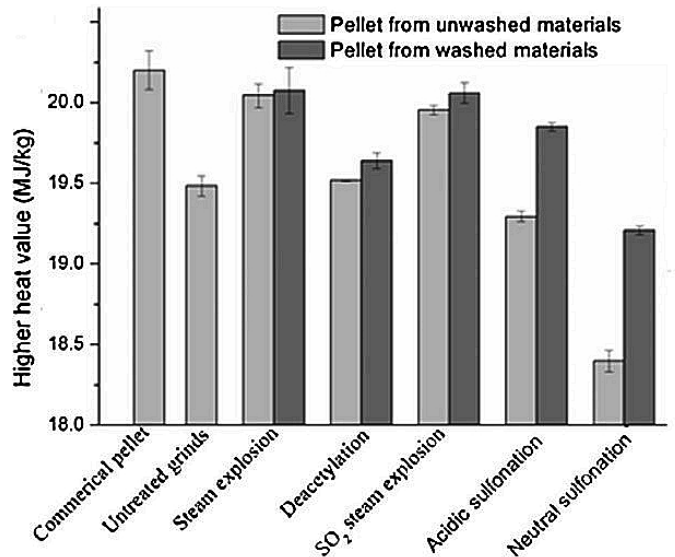
Figure 5. Comparison of the HHV of commercial pellet, raw pellet, and pretreated pellet. Adapted with permission from Ref. [83]. 2018, Elsevier.